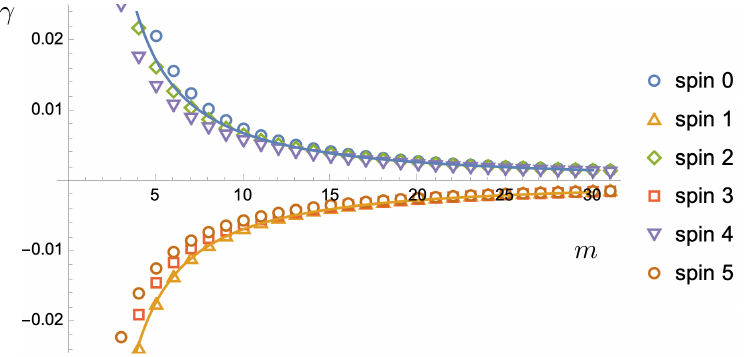
Figure 4 . A plot of the anomalous dimension γ ( m, ‘ ) as a function of level number m displaying the convergence to the asymptotic behaviour ± 0 . 147 m − 4 by the solid curves for even and odd spins,